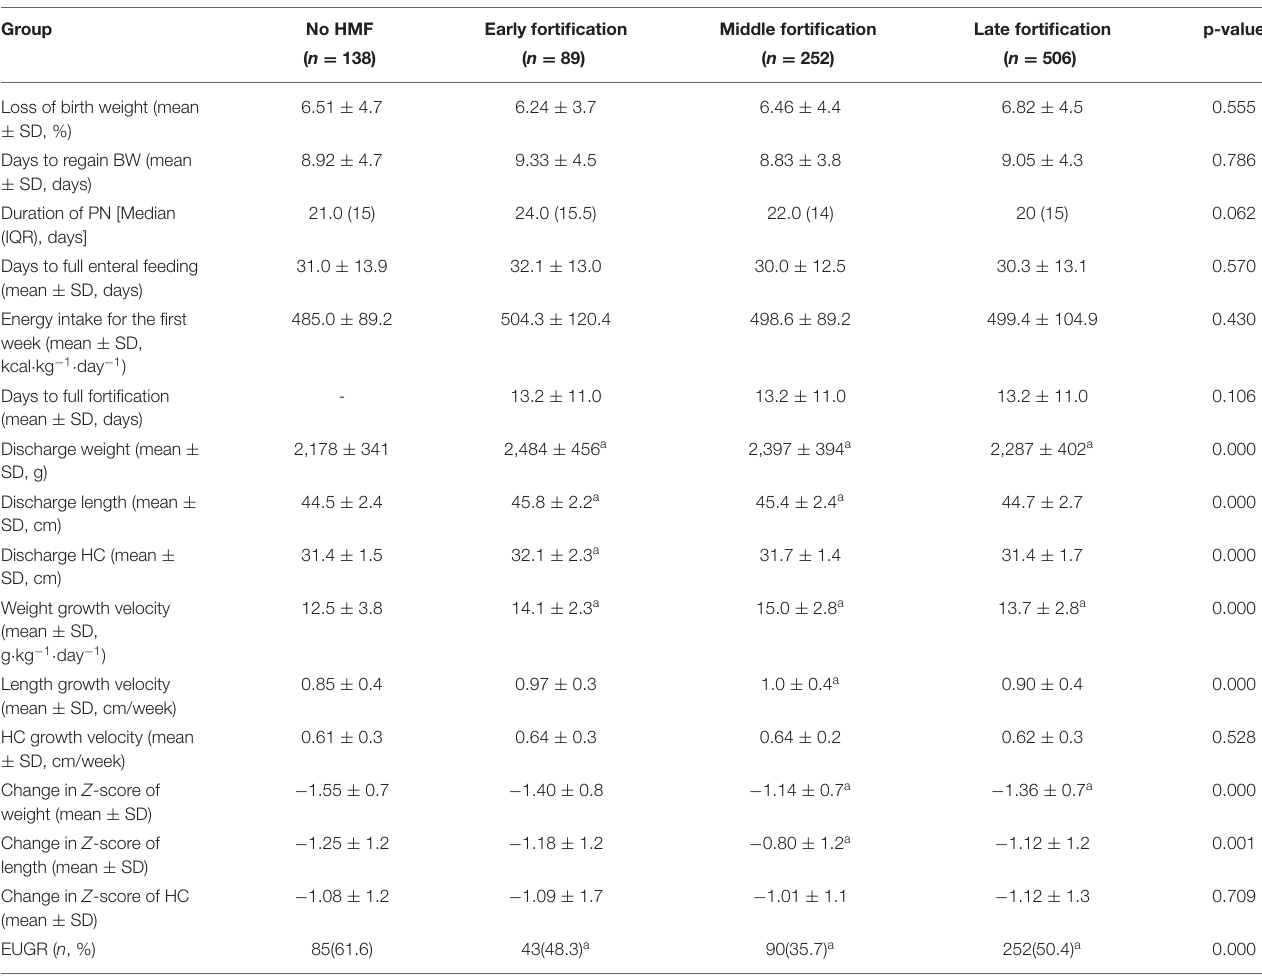
TABLE 3 | The comparison of nutritional status. Group